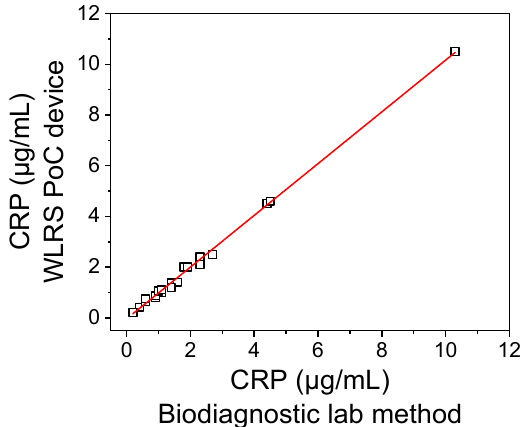
Figure 6. Correlation of CRP concentrations determined in 20 plasma samples from anonymous donors by the assay run on the WLRS PoC device with those obtained for the same samples by the diagnostic laboratory method.